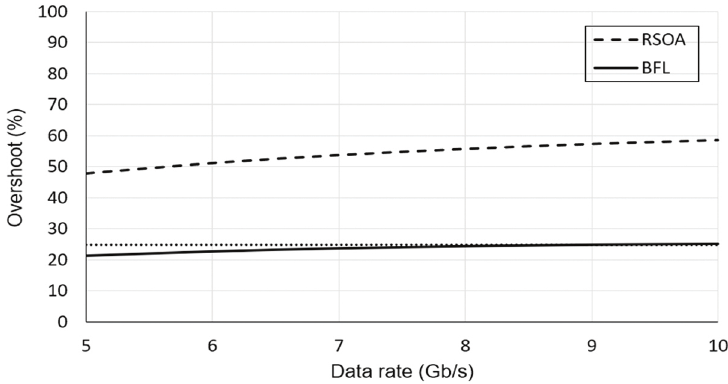
Figure 12. Overshoot at RSOA and BFL output for different data rates. The dotted horizontal line denotes the OVS acceptable limit set at